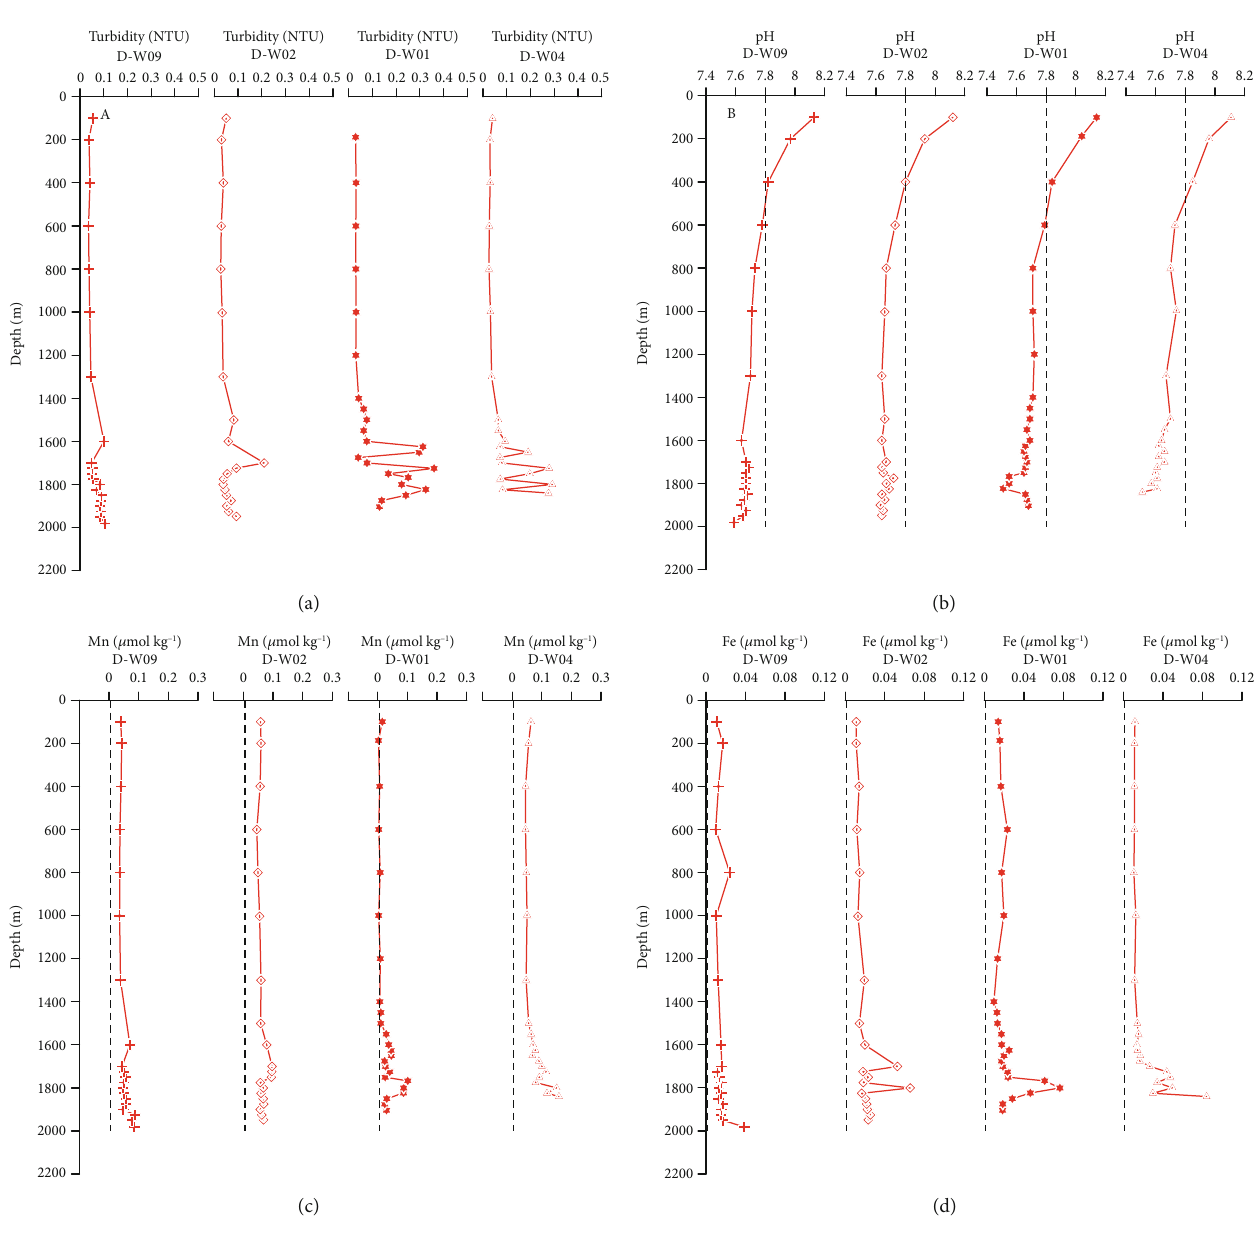
Figure 3: (a) Turbidity, (b) pH, (c) Mn, and (d) Fe anomalies in the water columns at the Desmos hydrothermal fi eld (stations D-W09, D- W02, D-W01, and D-W04). The seawater composition (vertical dashed line) was obtained from Seewald et al. [31] and Douville et al.